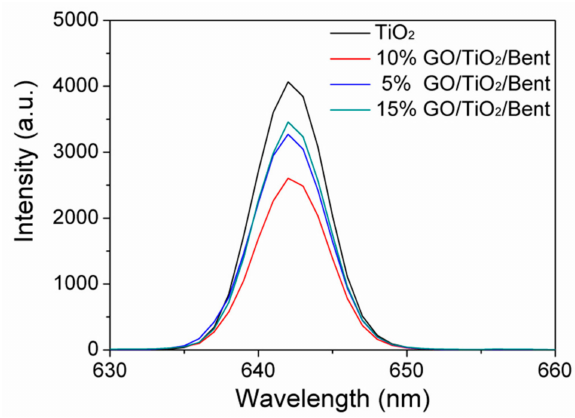
Figure 11. Photoluminescence (PL) spectra of TiO 2 and GO / TiO 2 / Bent